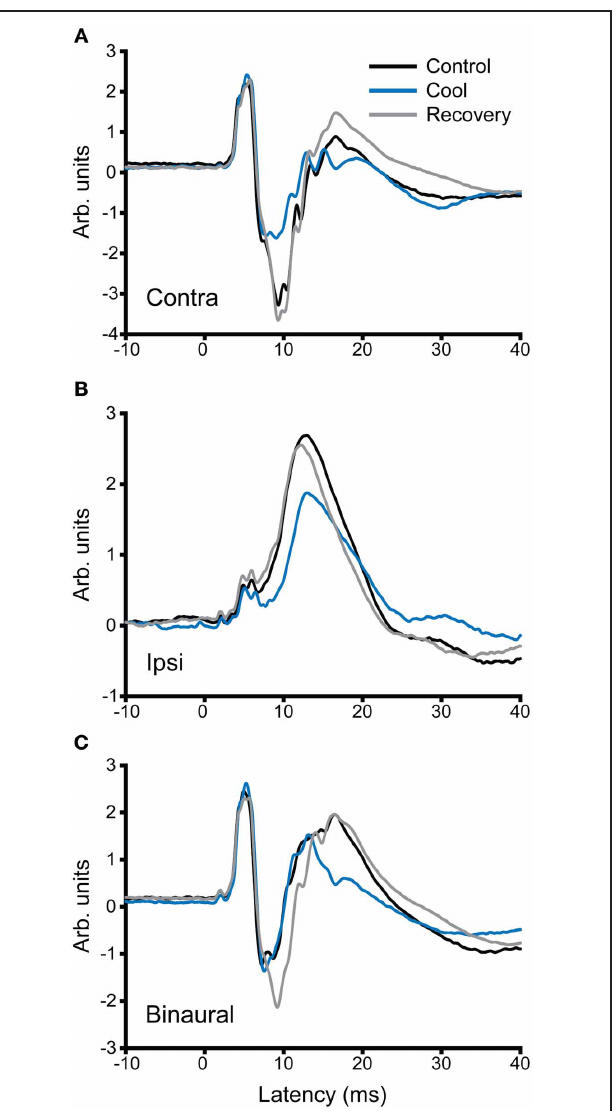
FIGURE 12 | Averaged local field potentials (100 sweeps) recorded in the IC in response to stimuli (1-ms duration tone pulses) presented at time zero to (A) the ear contralateral to the recorded IC, (B) the ipsilateral ear, and (C) binaural stimulation. Responses are shown for control conditions (black), during cooling (blue) and rewarming (gray) of the contralateral IC. Cooling has little effect on the first peak in the waveform, but changes the amplitude and time course of components occurring at and after 10ms post stimulus